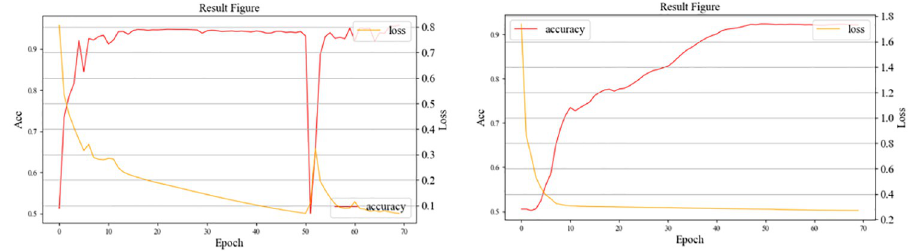
Fig 11. Evolution of the loss functions during